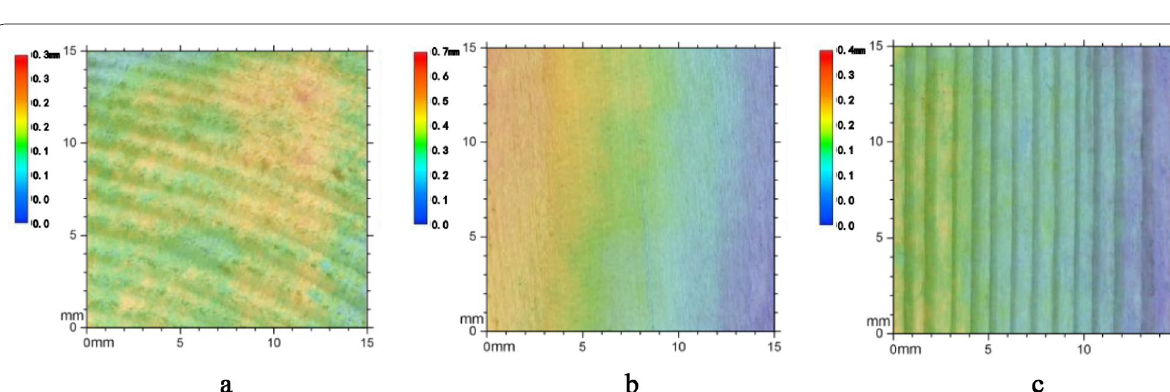
Fig. 11 3D profile of specimens with 400 mesh sandpaper grinding: a transverse section; b tangential section; c radial